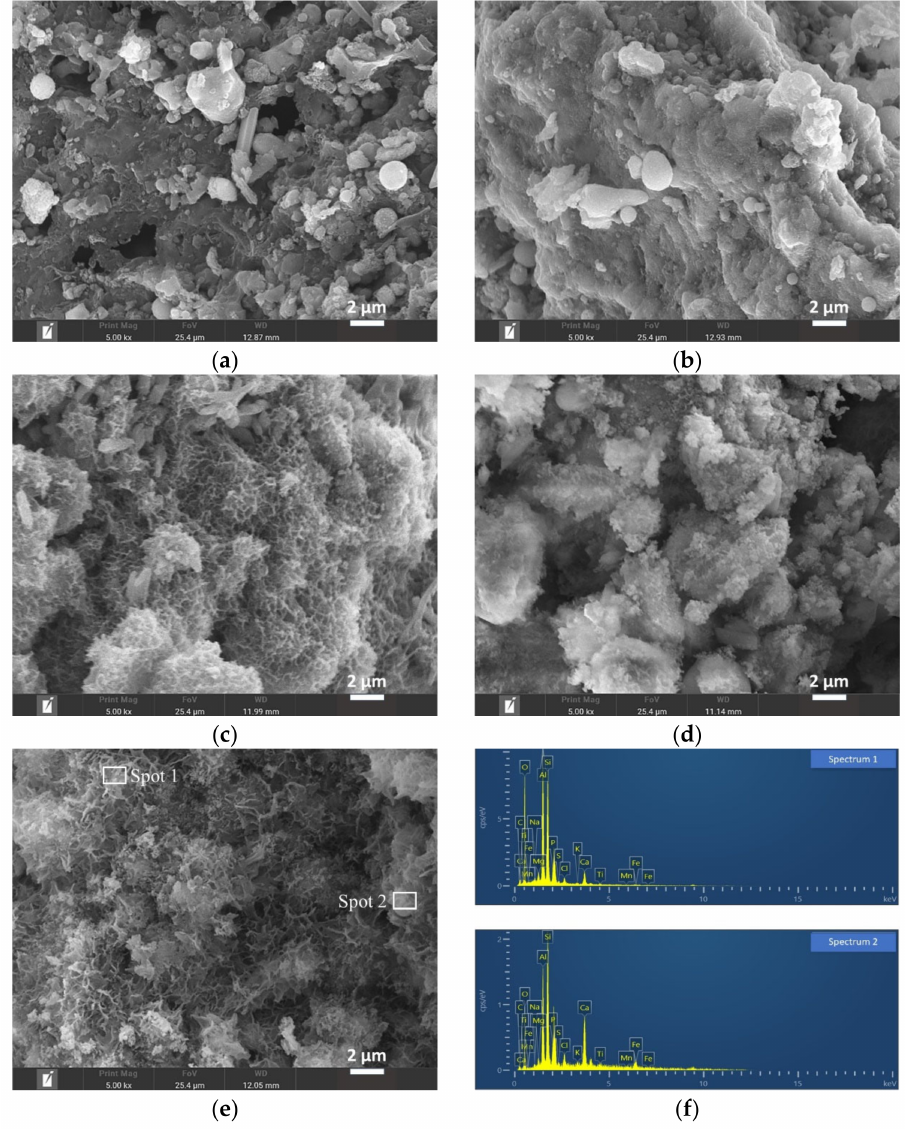
Figure 5. The SEM images and EDS spectra of paste (G5) and controls (G1, G2, G3, and G4) at 90 d: ( a ) SEM of G1, ( b ) SEM of G2, ( c ) SEM of G3, ( d ) SEM of G4, ( e ) SEM of G5, and ( f ) EDS spectra of spot 1 and spot